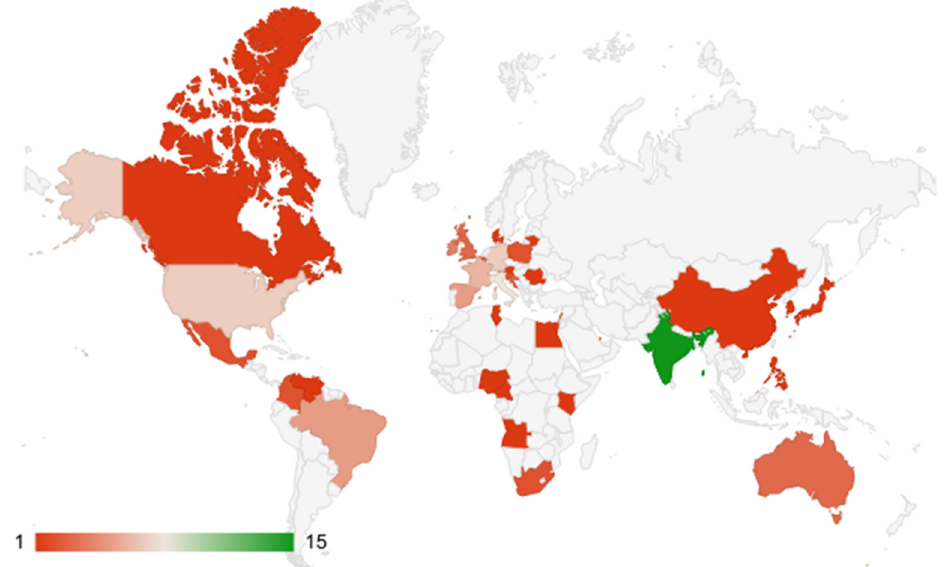
Figure 4. Countries involved in the survey shown on the map. Different colours indicate different representations of survey respondents. Red colour—low percentage; green colour—high percentage; total n of respondents was 99.